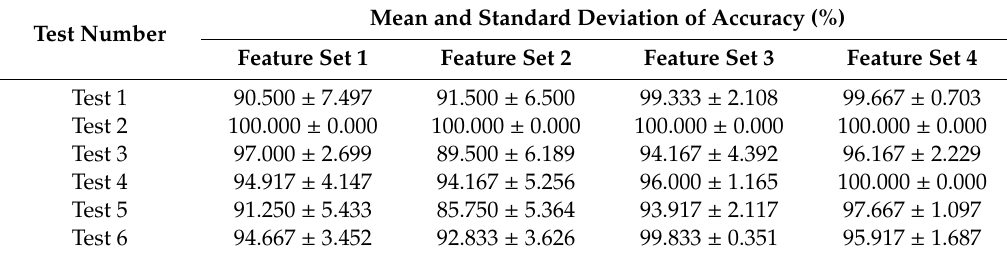
Figure 9. Accuracy (mean and standard deviation) for the internal and external test sets under 10-fold cross validations: ( a ) accuracy (mean and standard deviation) for internal test set; ( b ) accuracy (mean and standard deviation) for external test set. Table 4. Accuracy (mean and standard deviation, %) of internal testing under different test number.